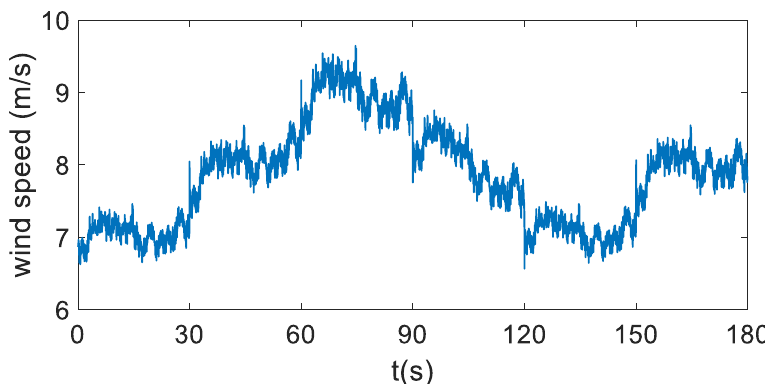
Figure 7. The wind speed in low wind speed region with severe turbulence.